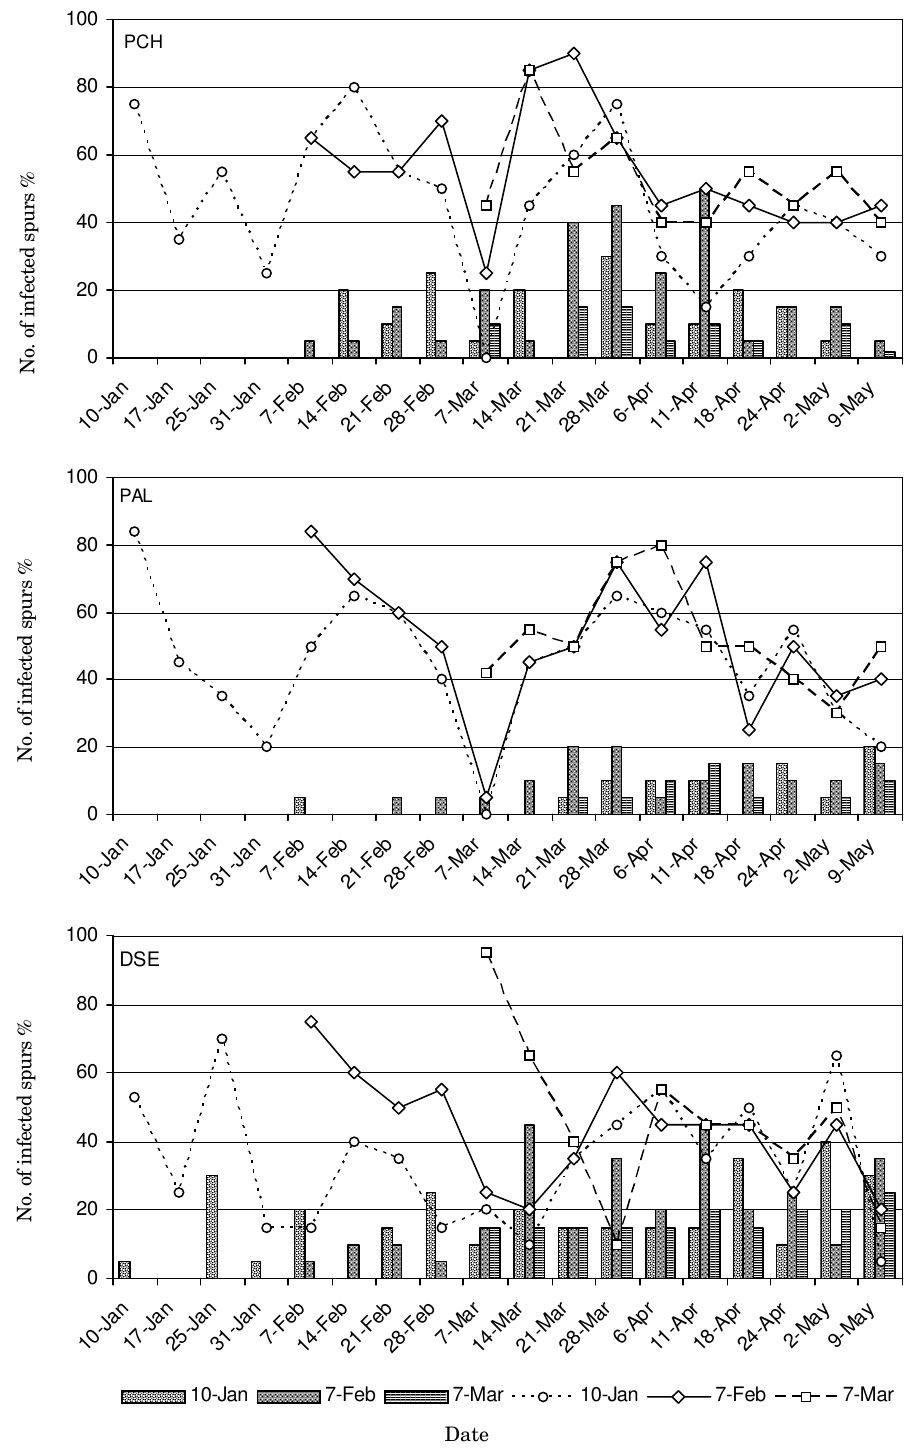
Fig. 4. Weekly infection percentages of spurs pruned in January, February and March and arti fi cially inoculated (dotted lines) or naturally infected (bars) with Phaeomoniella chlamydospora (PCH), Phaeoacremonium aleophilum (PAL) or Diplodia seriata (DSE) in